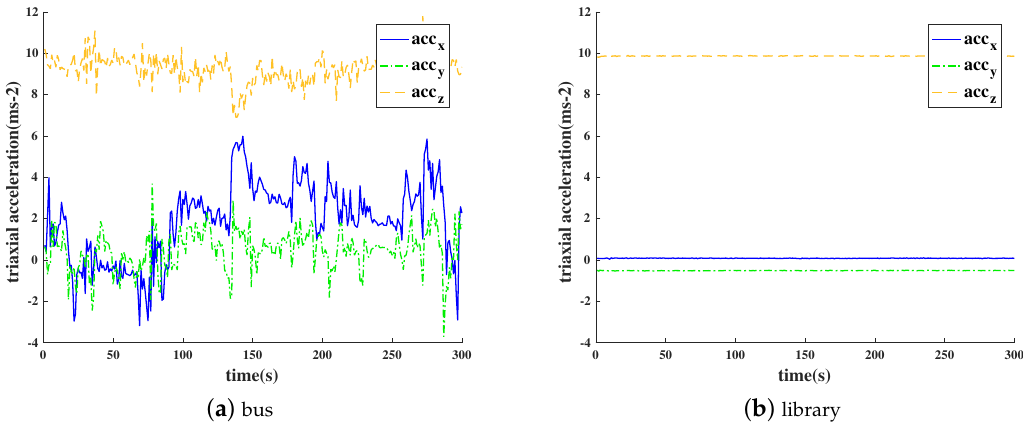
Figure 1. Acceleration sensor data over time in different environments. ( a ) Bus. ( b )